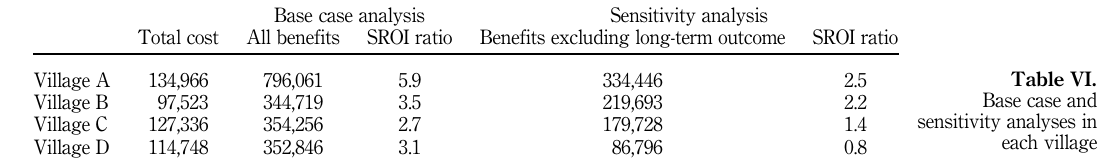
Table VI. Base case